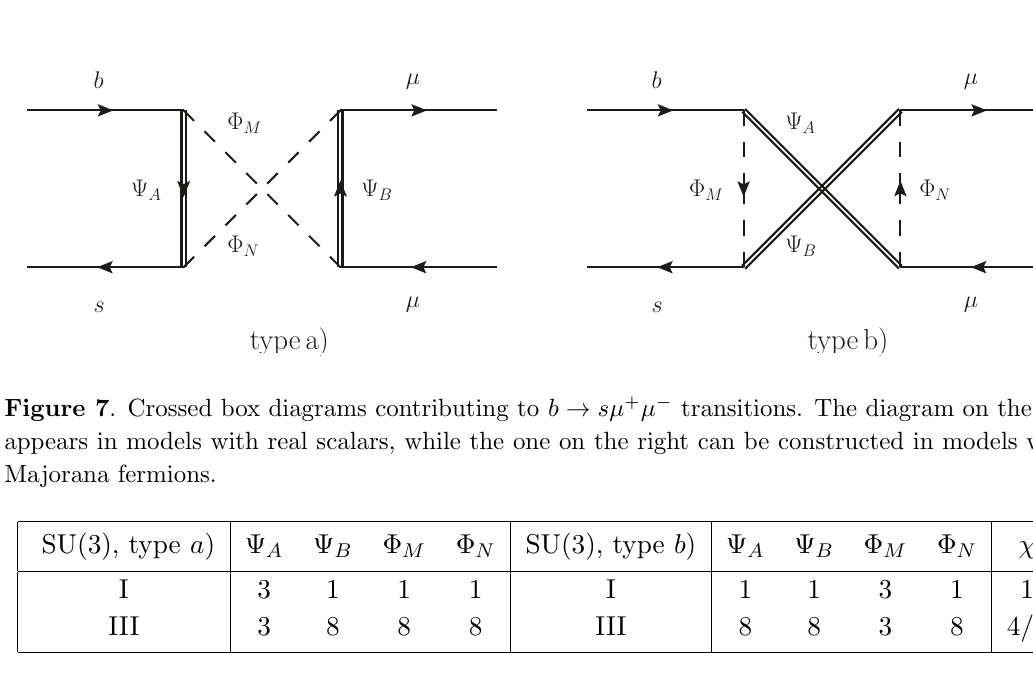
Table 5 . Table of SU(3)-factors entering the box induced Wilson coe(cid:14)cients involved in b ! s transitions for real scalars, type a ), and Majorana fermions, type b ). The numbers of each representation refer to the ones in table